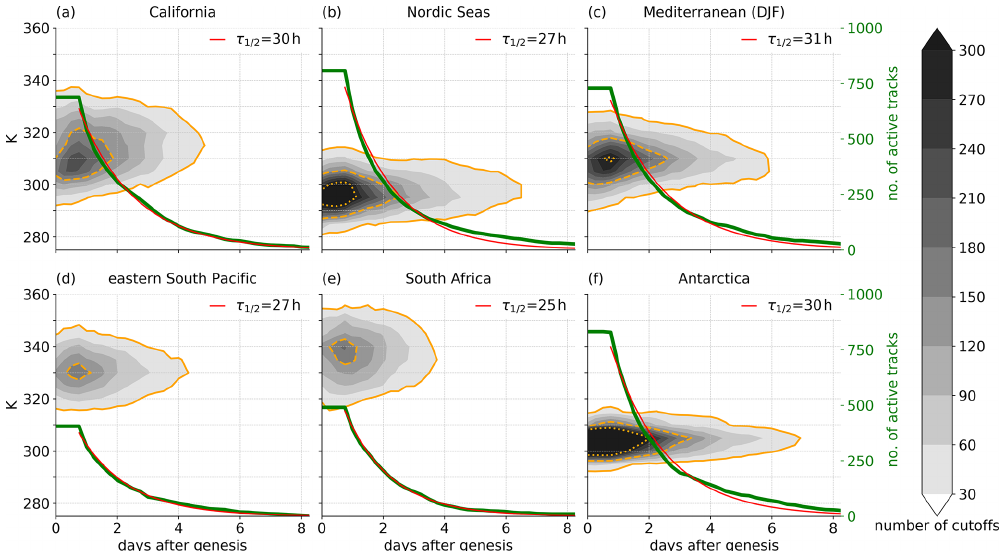
Figure 12. Number of PV cutoffs present on all isentropic levels (shading) and total number of active cutoff tracks (green curve), i.e., tracks that still persist at a certain time after genesis, and an exponential function fitted to the number of active tracks after a lifetime of one day (red curve) as a function of lifetime for PV cutoffs with genesis over the six selected regions in DJF: (a) California, (b) Nordic Seas, (c) Mediterranean, (d) eastern South Pacific, (e) South Africa, and (f) Antarctica. Values in the upper right corners correspond to PV cutoff half lives. Orange contours mark frequencies of (solid) 30, (dashed) 150, and (dotted) 300